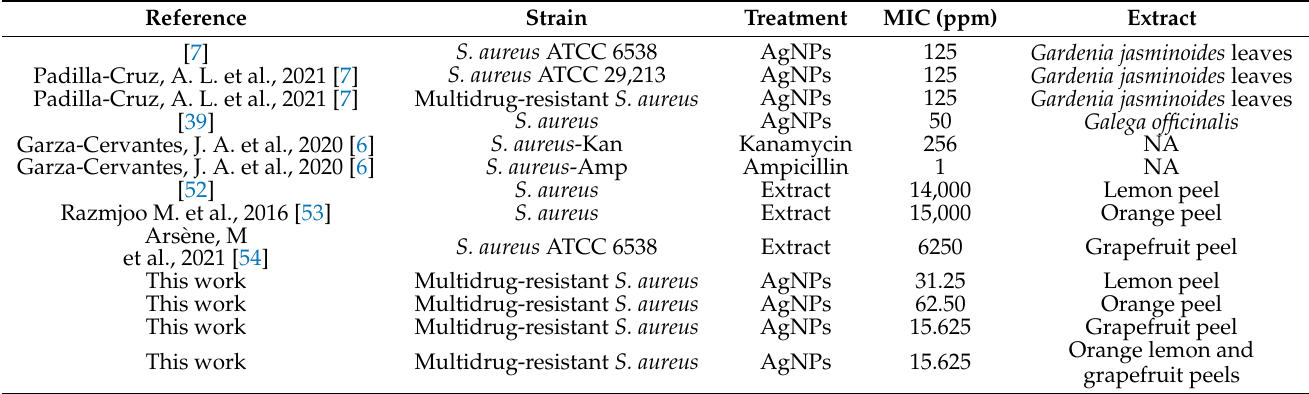
Table 1. S. aureus MICs from different